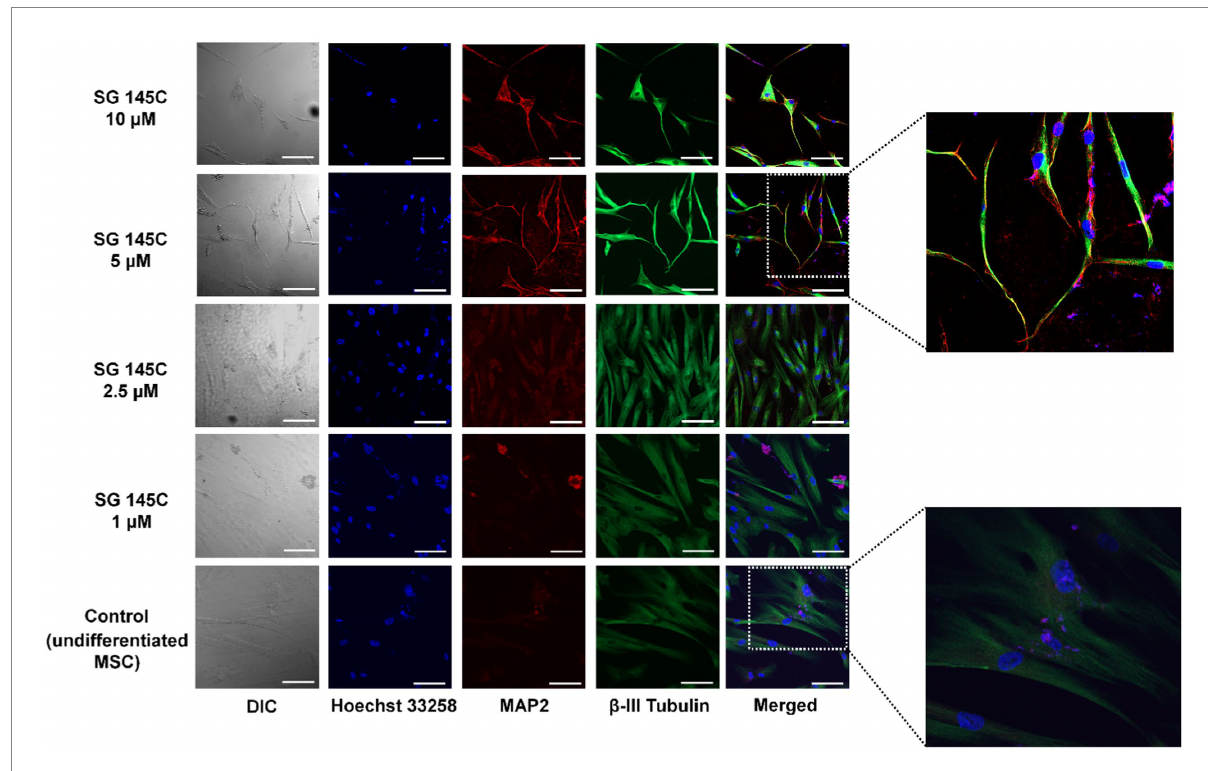
FIGURE 3 Evaluation of optimum dose of SG-145C for transdifferentiation. An increasing gradient of SG-145C was used to treat MSCs and immunofluorescence study of neuronal markers β -III Tubulin (AF-488) and Map2 (AF-543) performed to elucidate the optimal concentration. Images were captured in 20× magnification where the scale bar corresponds to 70 μ